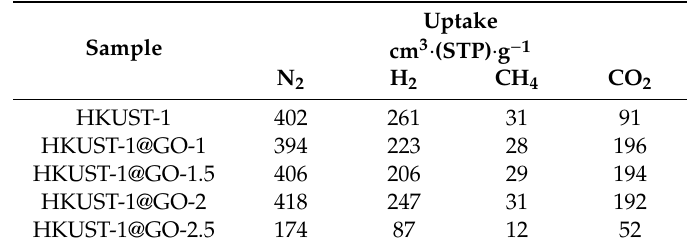
Table 2. Comparison of the adsorption capacities at atmospheric pressure for N 2 and H 2 at − 196 ◦ C, CH 4 and CO 2 at 0 ◦